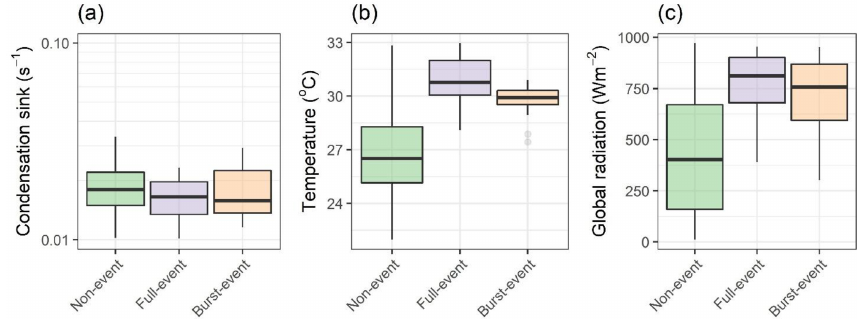
Figure 2. Box plots for days of non-event, full-event and burst-event, showing (a) condensation sink, (b) temperature, and (c) global radiation from hourly data. “Full-event” and “burst-event” include data across the entire